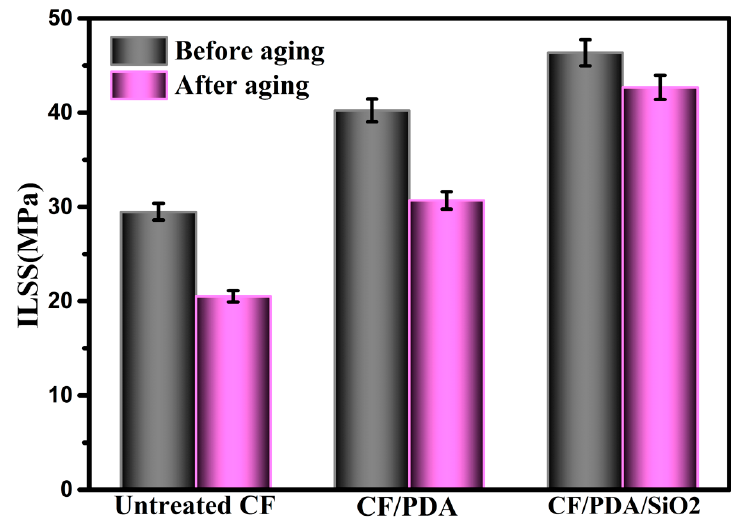
Figure 8. ILSS of composites before and after hydrothermal aging treatment.